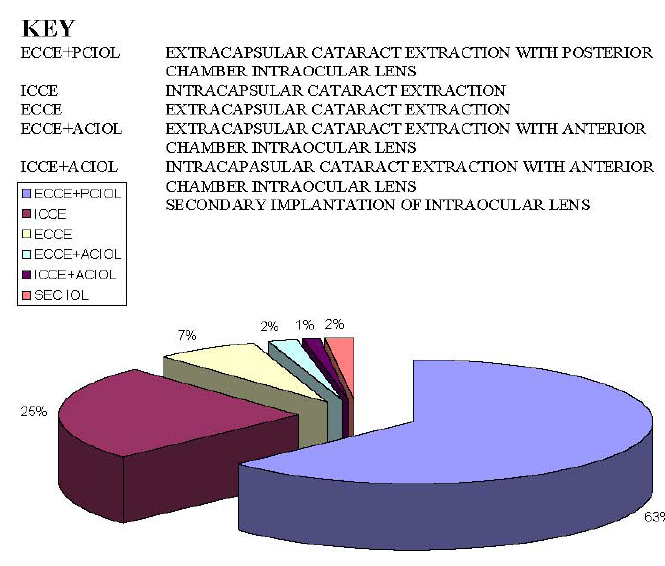
Figure 1 Types of surgery carries out between 2002 and 2006